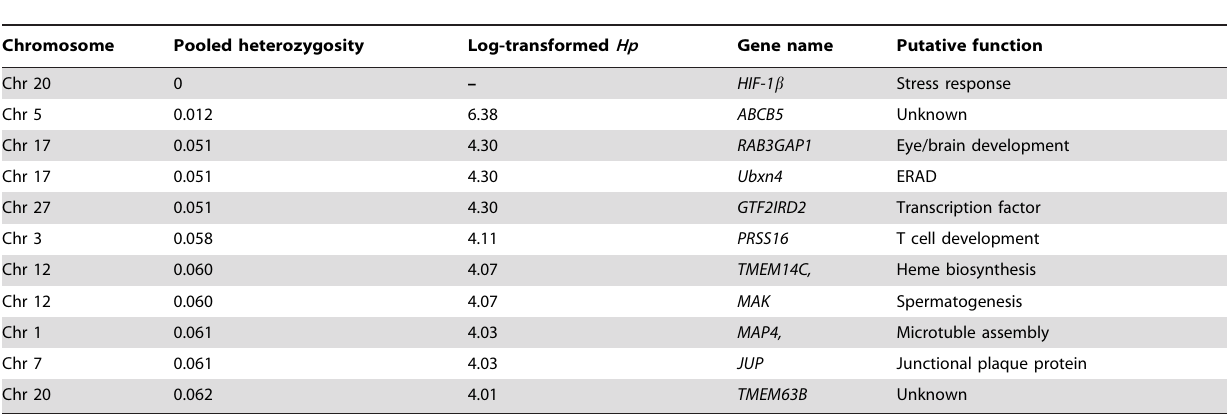
Table 6. List of genes identified from the regions with selective sweeps and their chromosomal location, pooled heterozygosity score and putative functions for channel